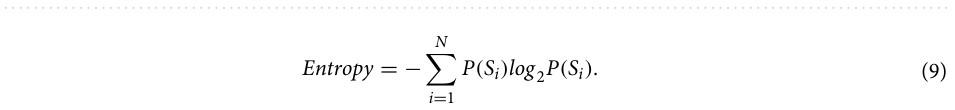
Figure 9. Output bitstreams of the PRNG represented as images in four cases: ( a ) key K 1 , ( b ) key K ∗ 1 , ( c ) key K 2 , and ( d ) key K 3